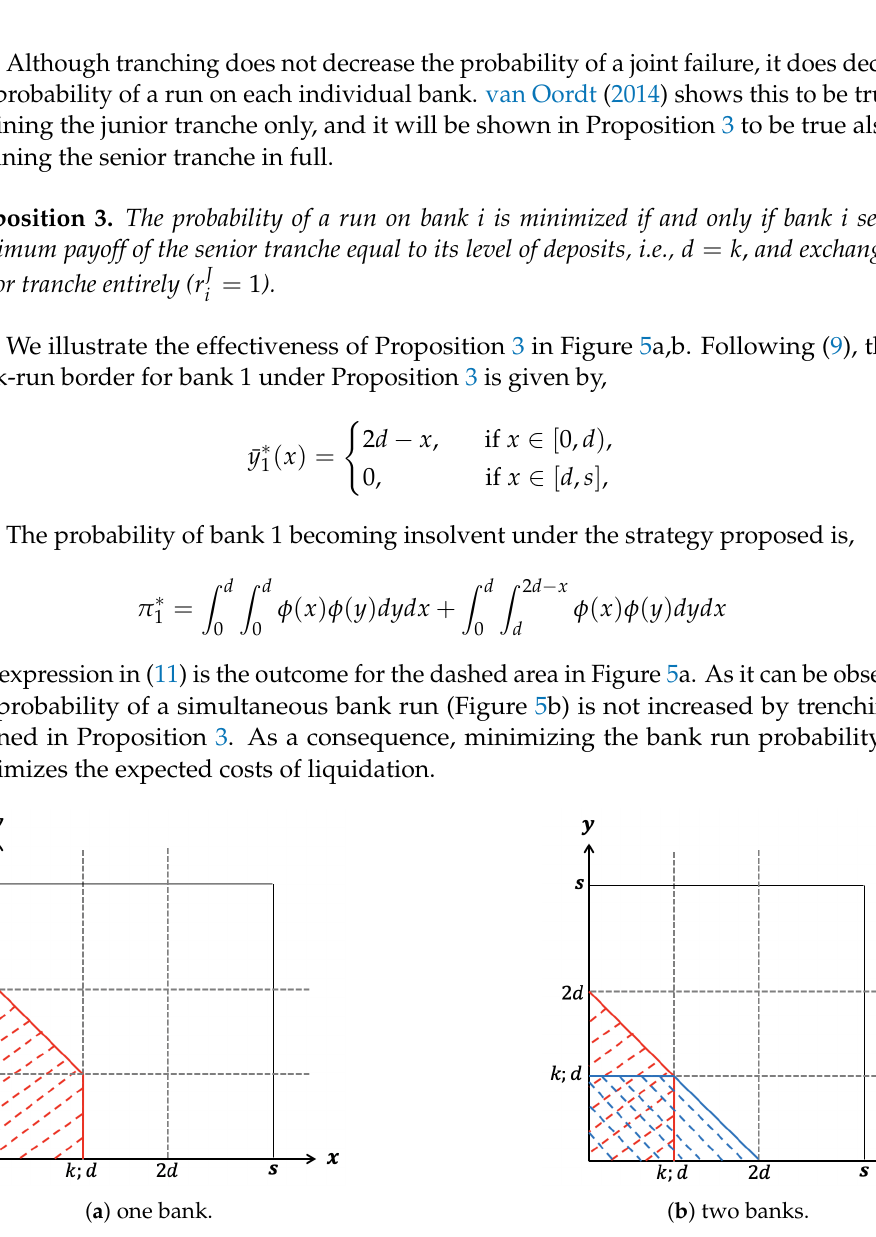
Figure 5. Bank run outcomes for the optimal diversification strategy in case of securitization with keeping junior